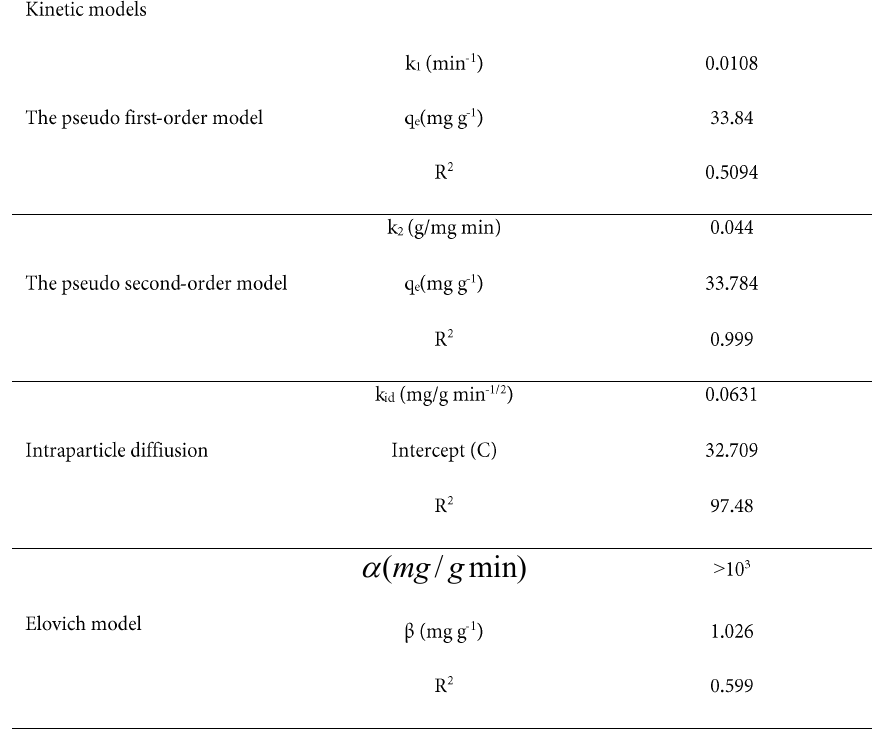
Table 1. Kinetic parameters for Cs(I) sorption by GO-NiHCF ( contact time interval 10-300 min, at 25°C and pH 7 with continuous shaking at 150